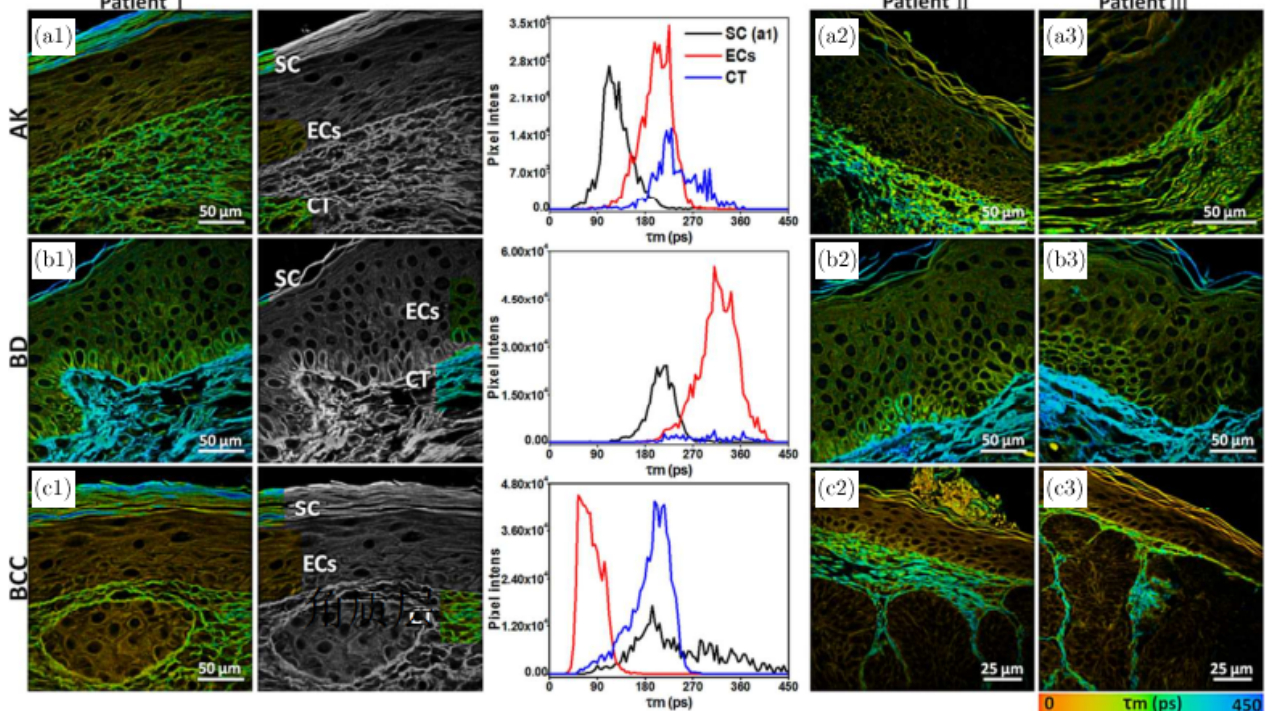
Fig. 6. (a1) – (a3) FLT images of H&E stained actinic keratosis (AK) sections, three randomly selected FLIM images from the ROIs and their corresponding average °uorescence lifetimes ( (cid:1) m) histograms; (b1) – (b3) FLT of H&E stained Bowen's disease (BD) sections; (c1) – (c3) FLT of H&E stained BCC sections. The corresponding continuous color coding scheme ranges from 0 ps (red) to 450 ps (blue). For per patient and per section, the (cid:1) m of SC, ECs and CT were counted randomly in nine selected ¯elds within the whole slide (For each lesion, the total number of participating statistics in each skin layer is 27).